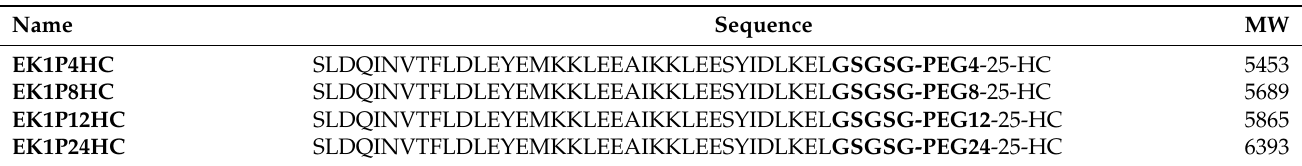
Table 1. Sequences of 25-HC-modified EK1